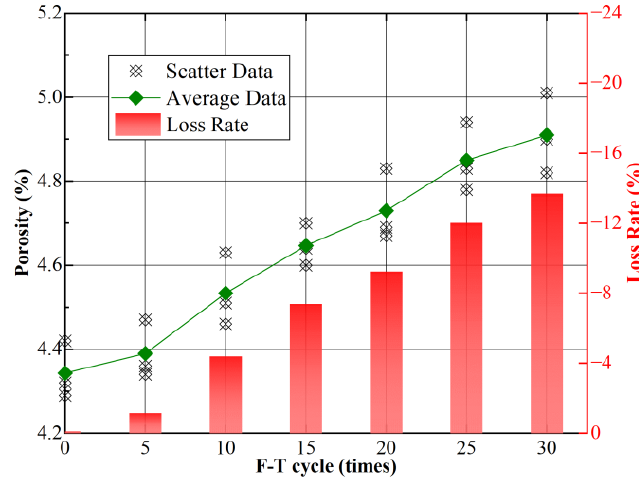
Figure 6. The average porosity and loss rate with cycles in tested sandstone.